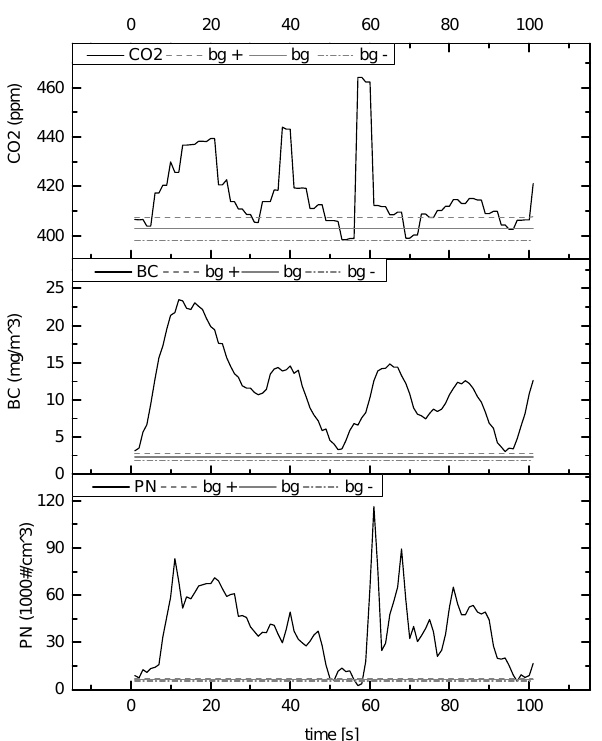
Figure 2. An example of chasing plume measurements (black solid line). Background (bg), background + and − and 2 standard devia- tions of background are shown in grey solid, dashed and dash-dotted line,